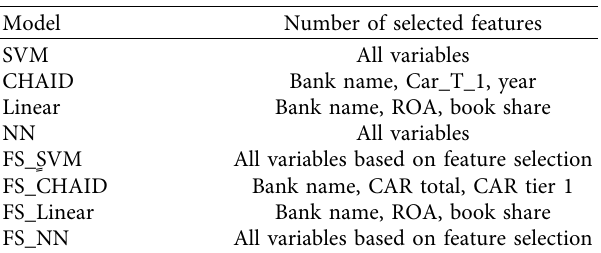
Table 5: Used variable to build each model based on with/without feature selection